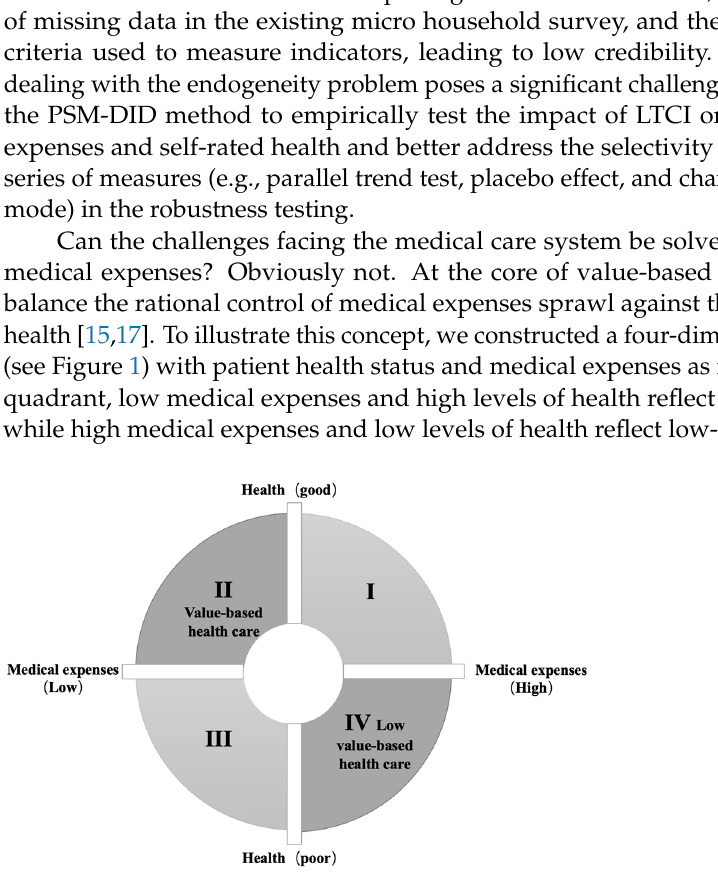
Figure 2. Trends in life expectancy and health expenditure by country, 2000–2019. Note: This visu ‐ alization shows the cross ‐ country relationship between life expectancy at birth (ordinate data) and healthcare expenditure per capita (abscissa). Arrows connect these two observations, showing the change over time of both measures for all countries in the world. China is at the intersection of low ‐ value ‐ based healthcare and value ‐ based healthcare. Source: Image from https://our ‐ worldindata.org/ (accessed on 20 May 2022). The contribution of this paper is two ‐ fold: First, in a practical sense, most of the ex ‐ isting literature [23–25] focuses on the impact of LTCI on total medical expenses but ig ‐ nores out ‐ of ‐ pocket medical expenses. Compared with total medical expenses, out ‐ of ‐ pocket medical expenses can better reflect the role of individuals in terms of actual ex ‐ penditure [26]. Second, from a theoretical perspective, it helps enrich and expand our un ‐ derstanding of the LTCI microeconomic consequences from a value ‐ based perspective. The paper focuses on the economic benefits of LTCI from the perspectives of purchase decision ‐ making [27] and sustainability [28], and less focus is placed on whether LTCI can protect or even enhance the health of beneficiaries. In the remainder of this paper, we review the literature on the influences of LTCI on out ‐ of ‐ pocket medical expenses and self ‐ rated health and the reasons for the controversy. We then present our use of the PSM ‐ DID method to calculate the net effect of LTCI and complete a series of robustness tests. We discuss whether LTCI can control medical ex ‐ penses and protect the health of beneficiaries and conclude by presenting the contribu ‐ tions of our research findings and the study limitations.